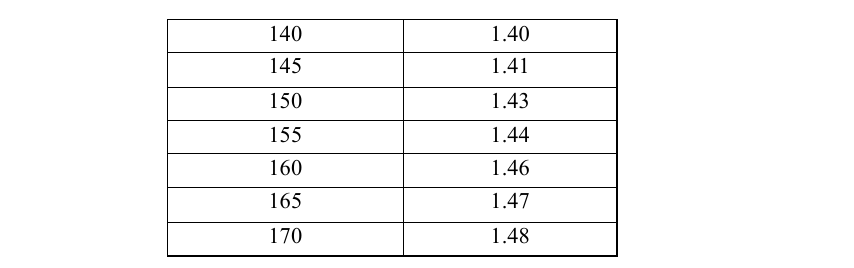
Figure 4: Experimental set-up for measurement of coupling